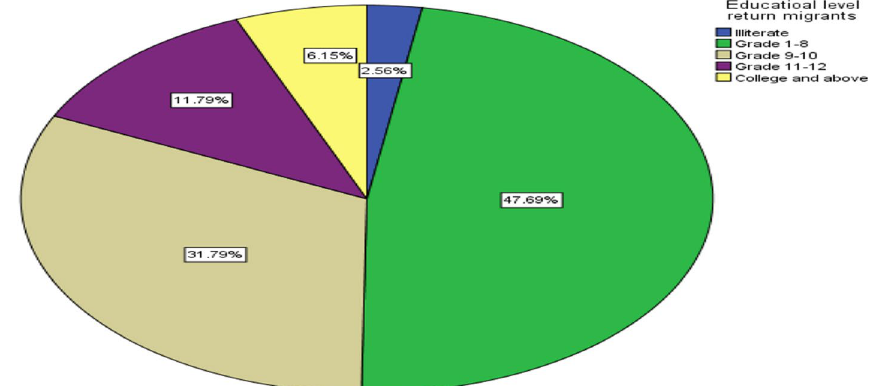
Fig. 2 Educational status of returnees. Source Field Survey Result,